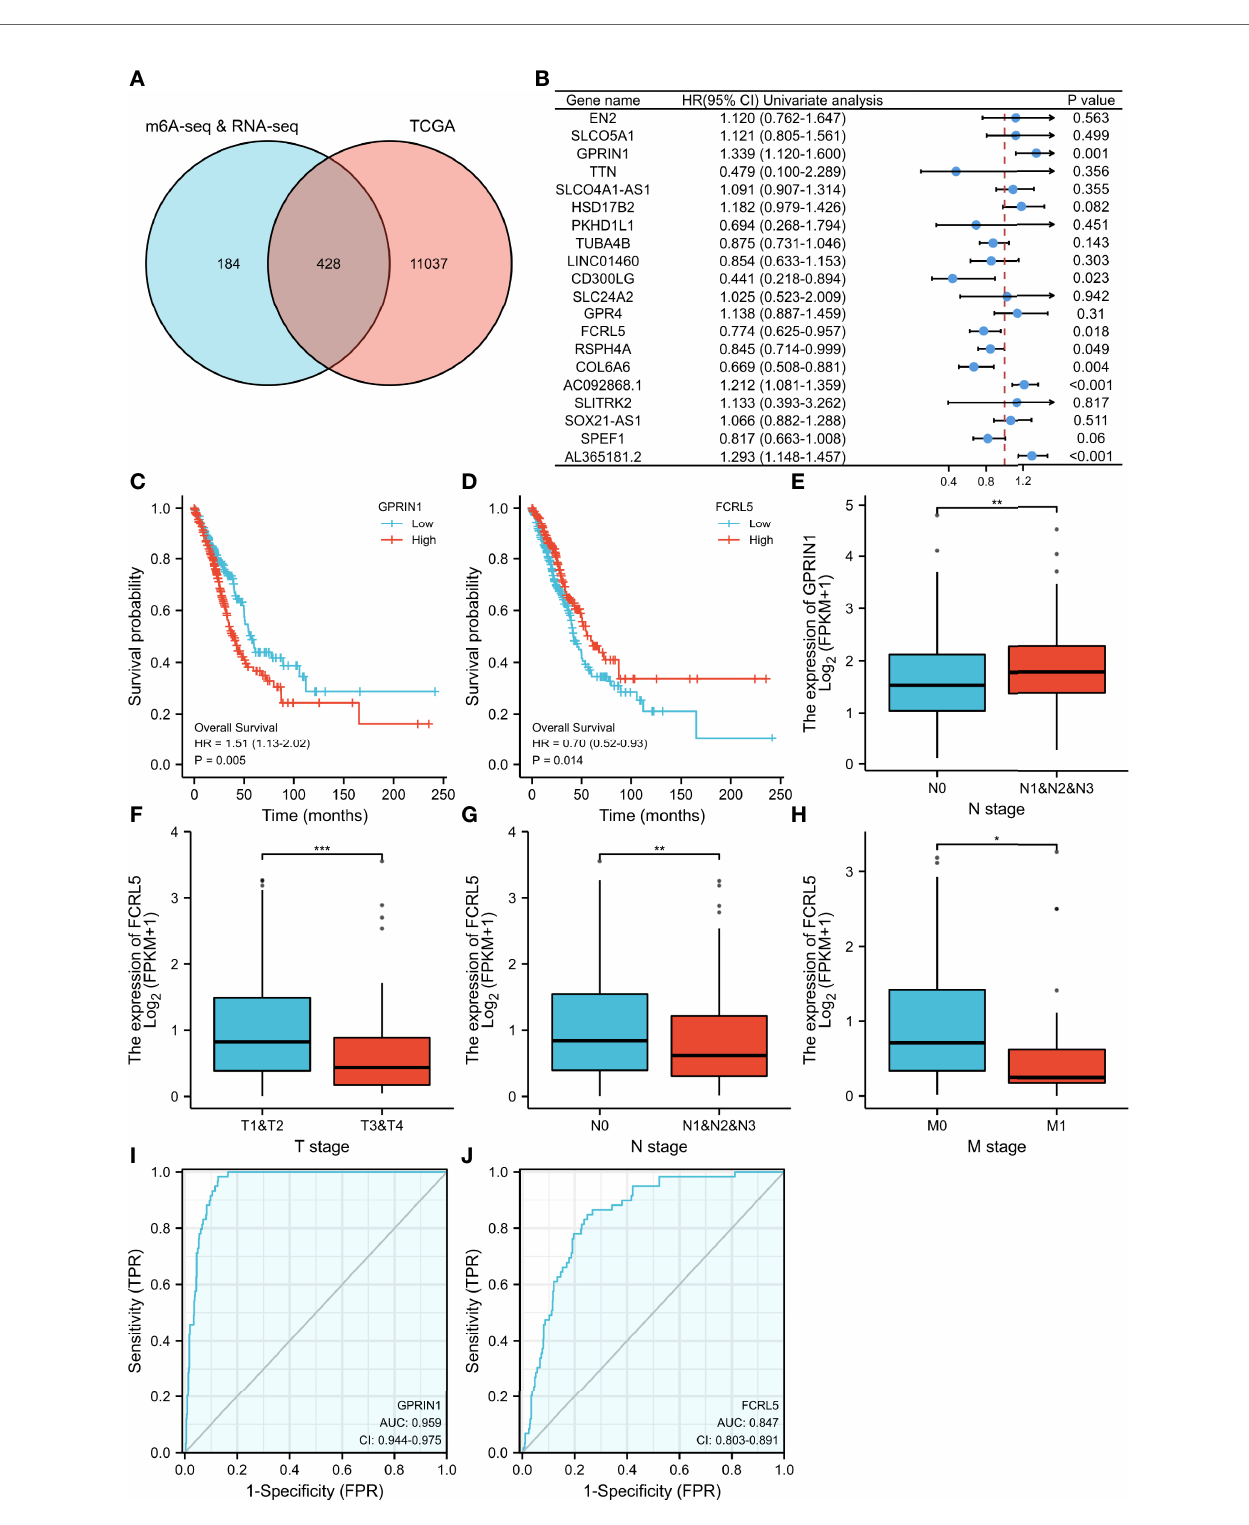
FIGURE 5 | The relationship between gene expression regulated by m6A modi fi cation and clinical parameters in the TCGA database. (A) The intersection of genes in our study and TCGA database. (B) 20 prognostic genes were identi fi ed via univariate Cox regression analysis. (C, D) Overall survival curves of GPRIN1 and FCRL5, respectively. (E) The relationships between GPRIN1 expression and N. (F, G, H) The relationships between FCRL5 expression and M, N, and clinical stage. (I, J) The ROC curves of GPRIN1 and FCRL5, respectively. P *<0.5, P **<0.01, P ***<0.001. (N: lymph node metastasis; M: distant